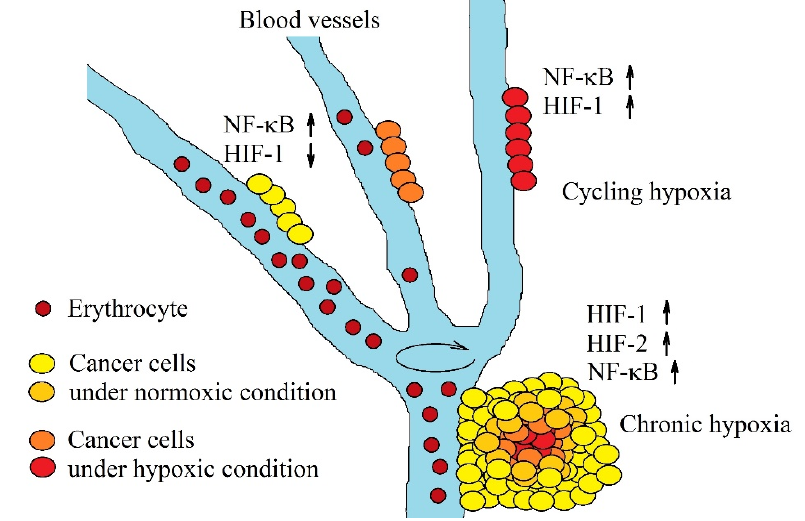
Figure 3. Two types of hypoxia in a tumor. Chronic hypoxia is associated with a long distance between the cells and the blood vessels that supply them with oxygen. This hypoxia induces an increase in activation of HIF-1 and HIF-2 and expression of hypoxia-inducible genes. The second type of hypoxia, cycling hypoxia, consists in blood flow through a given blood vessel in repeated cycles. The hypoxic stage is accompanied by the activation of NF-κB, and the activation of HIF-1. Reoxygenation is associated with the proteolytic degradation of HIF-1α and decrease in HIF-1 activation.